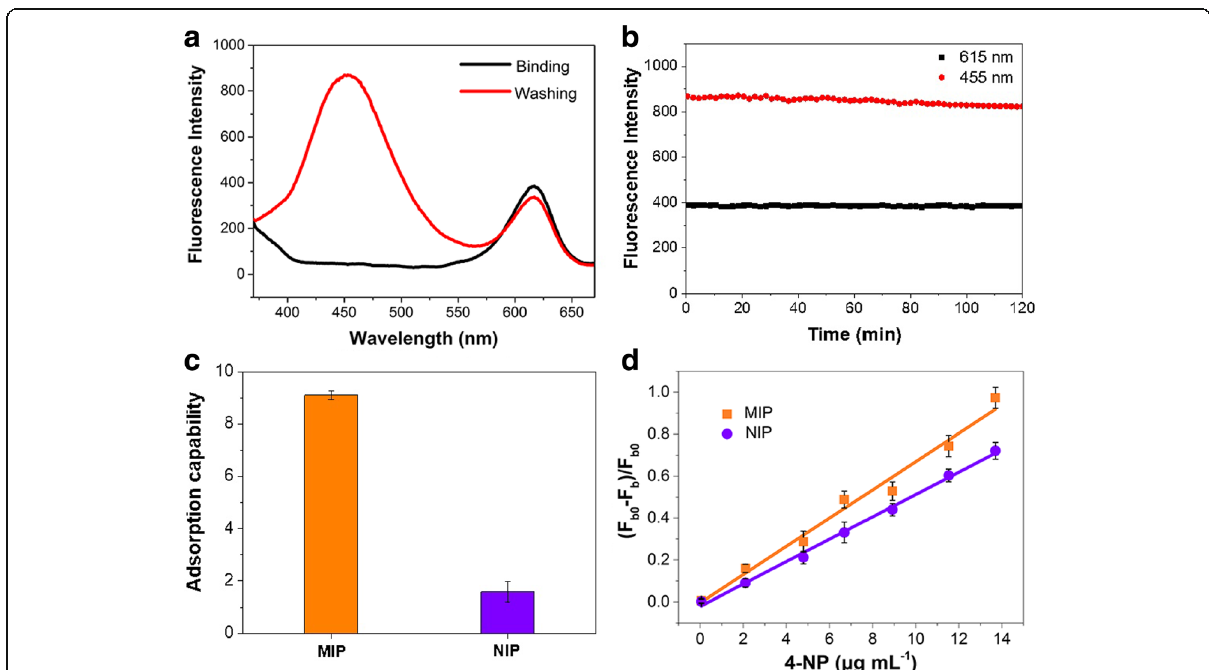
Fig. 2 Fluorescence of the prepared hybrid nanoparticles. a Fluorescence emission spectra of the CdSe@SiO 2 /CD/MIP nanoparticles before (black line) and after (red line) removal of the template molecules and b their photo-stability dispersed in ethanol following the removal of 4-NP. c Adsorption capacities of the CdSe@SiO 2 /CD/MIP and CdSe@SiO 2 /CD/NIP nanohybrids. d The plots of the fluorescence intensity of CdSe@SiO 2 /CDs/MIP and CdSe@SiO 2 /CDs/NIP with 4-NP, respectively. (F b0 and F b represent the fluorescence intensity of CdSe@SiO 2 /CDs/MIP and CdSe@SiO 2 /CDs/NIP at 455 nm in the absence and presence of various amounts of